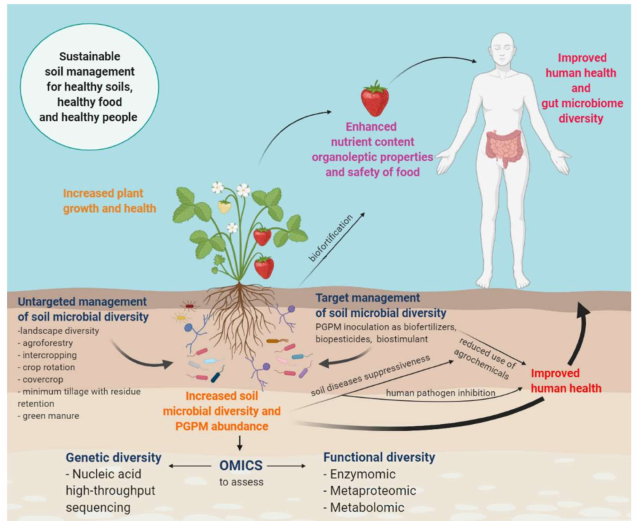
Figure 1. Both targeted and untargeted management of soil microbial diversity in the sustainable improvement of plant health, food crop yield, its nutritional quality and safety. The development of high-throughput technologies, called -Omics, applied to the study of soil microbial functional diversity will help strengthen the link between soil well-being, food quality, food safety and human